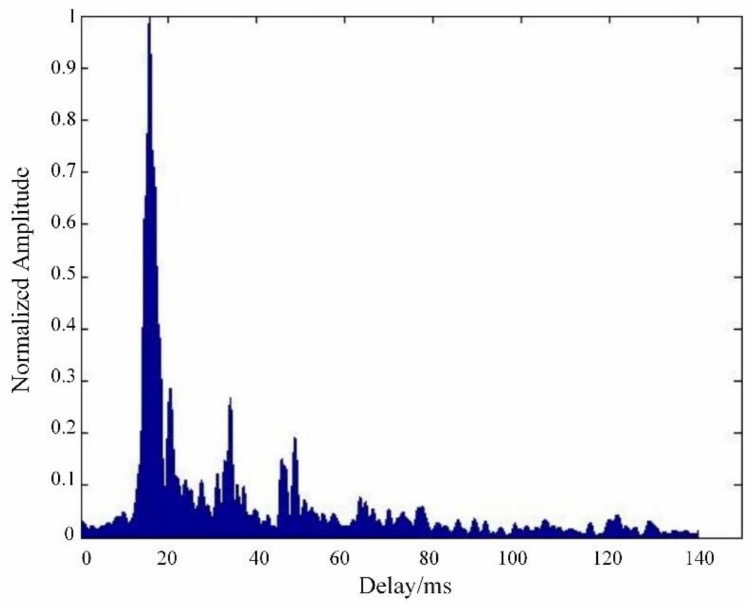
Figure 2. Channel Impulse